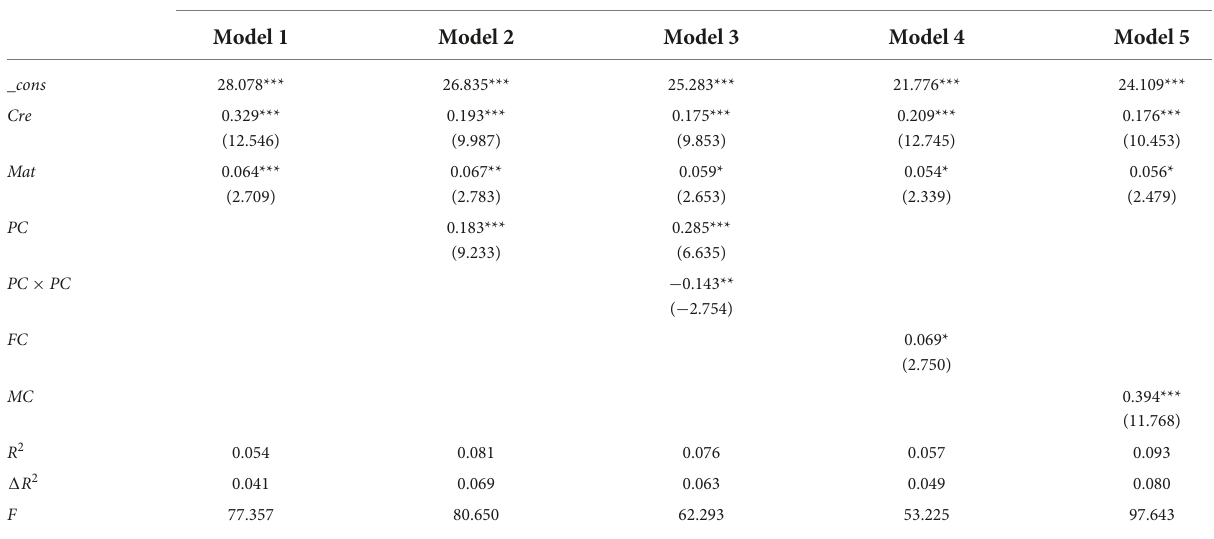
TABLE 4 Single stakeholder relationships → social goal-oriented regression analysis.